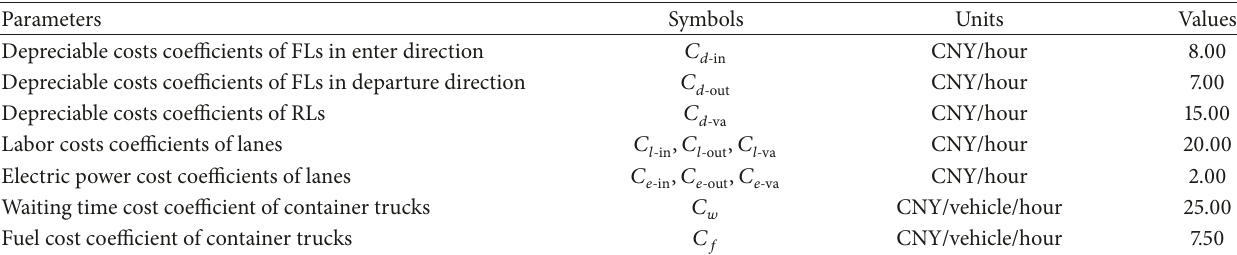
Table 2: Cost coefficients of lanes at container